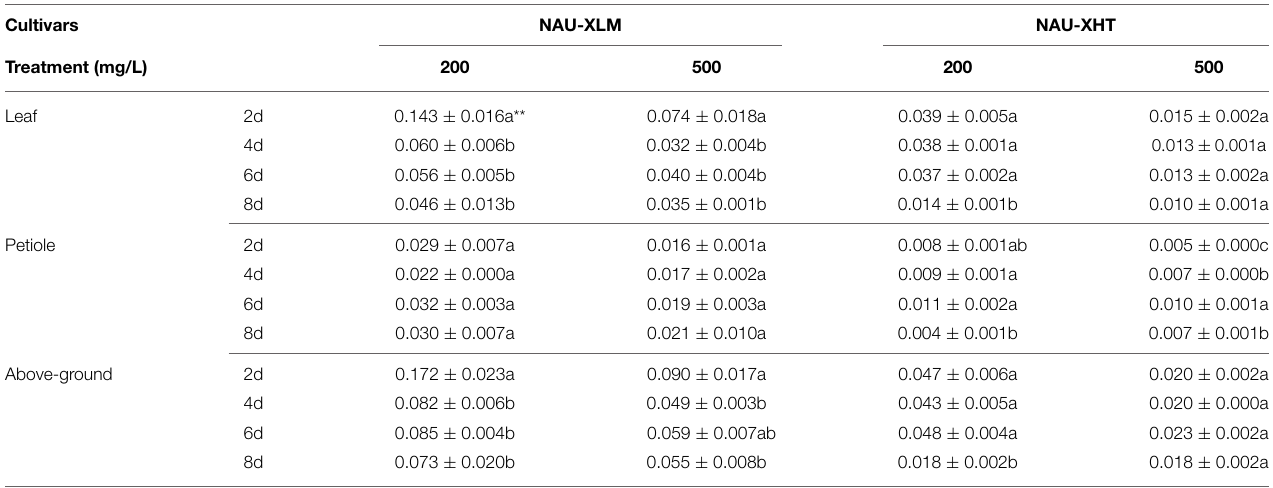
TABLE 1 | Translocation factors (TFs) in four time periods under two Pb treatments * .